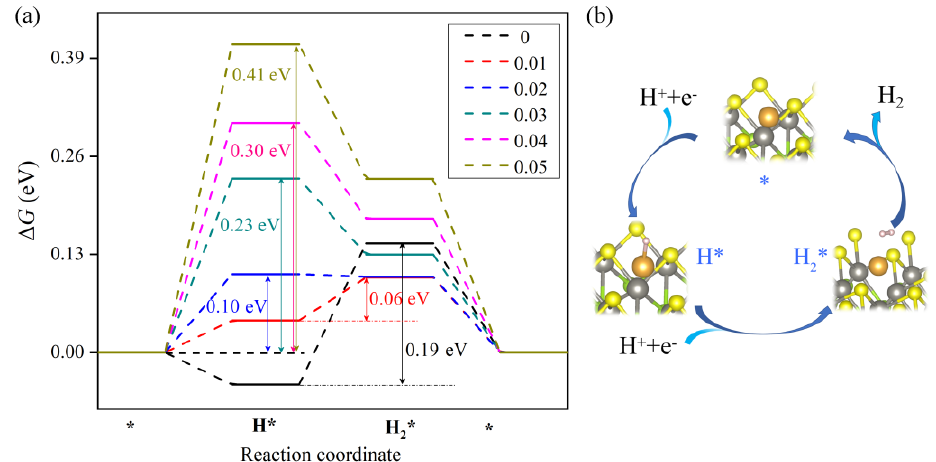
Figure 6. ( a ) The free-energy profile for electrochemical HER on Au/WSSe under different tensile strain. ( b ) The optimized configurations of the intermediates in the HER process. * stands for the adsorption site.